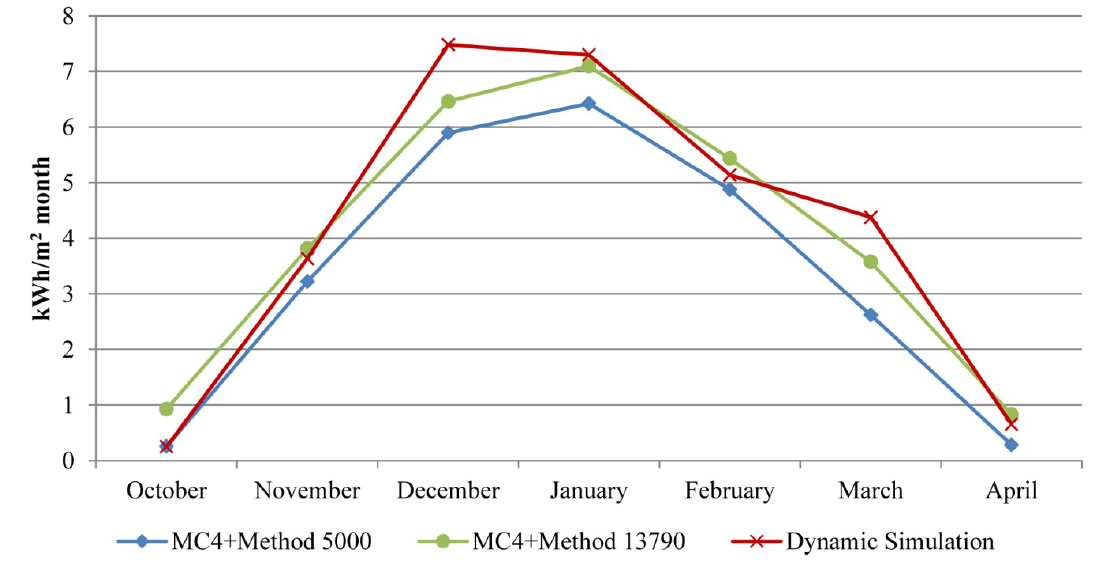
Figure 10. Monthly trend of the flat+ sunspace energy need for heating, evaluated with three different